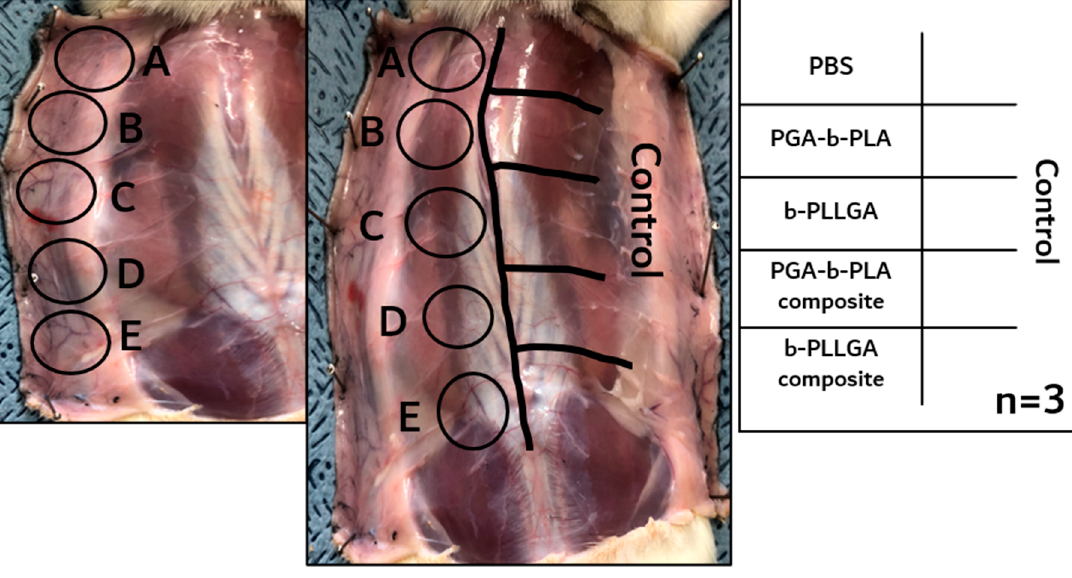
Figure 7. Intradermal intracutaneous reaction analysis of the extracted solution injection obtained 72 h after injection ( n = 3) using the samples PBS ( A ), PGA–b-PLA ( B ), b-PLLGA ( C ), the PGA–b-PLA composite ( D ), and the b-PLLGA composite ( E ).